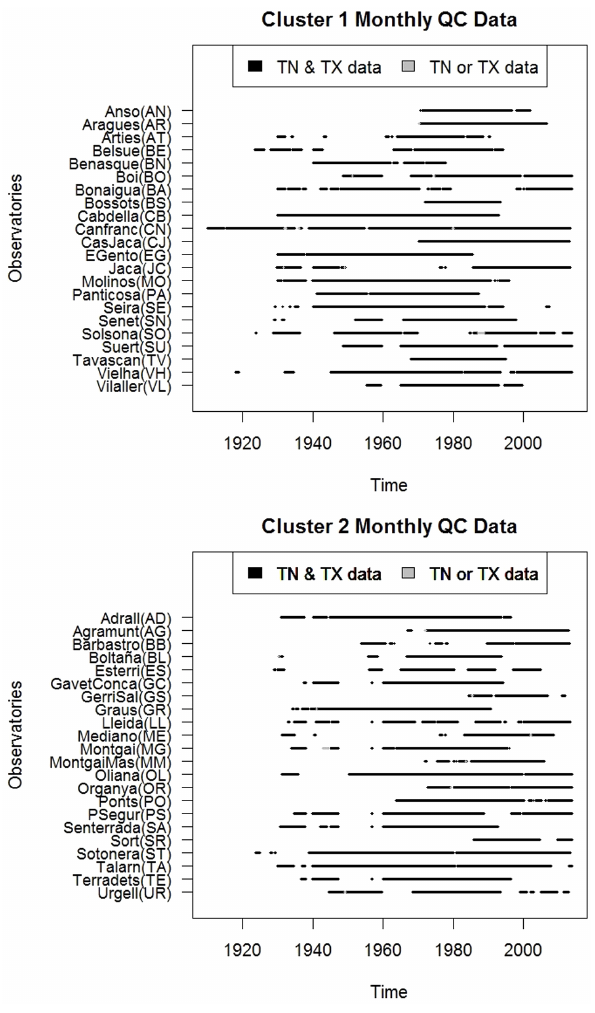
Figure 2. The temporal coverage of monthly maximum ( T X ) and minimum ( T N ) temperature data for each climatological